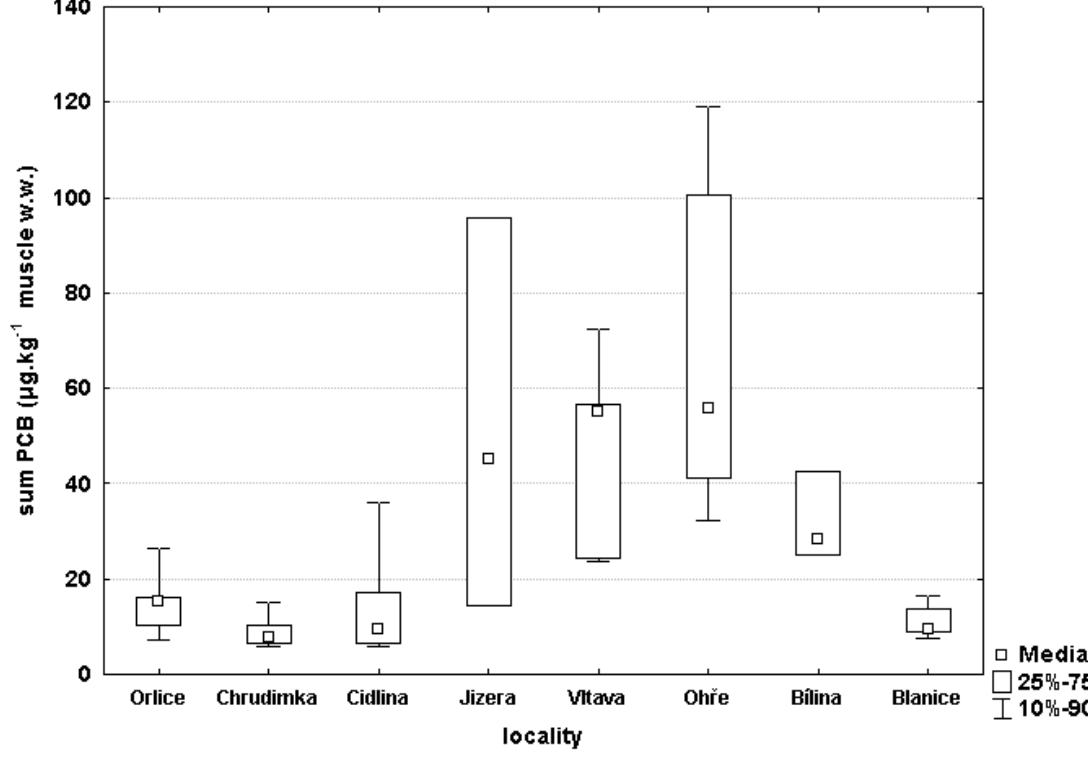
Figure 3. Content of PCB (sum of 7 indicator congeners) in male chub muscle samples (wet